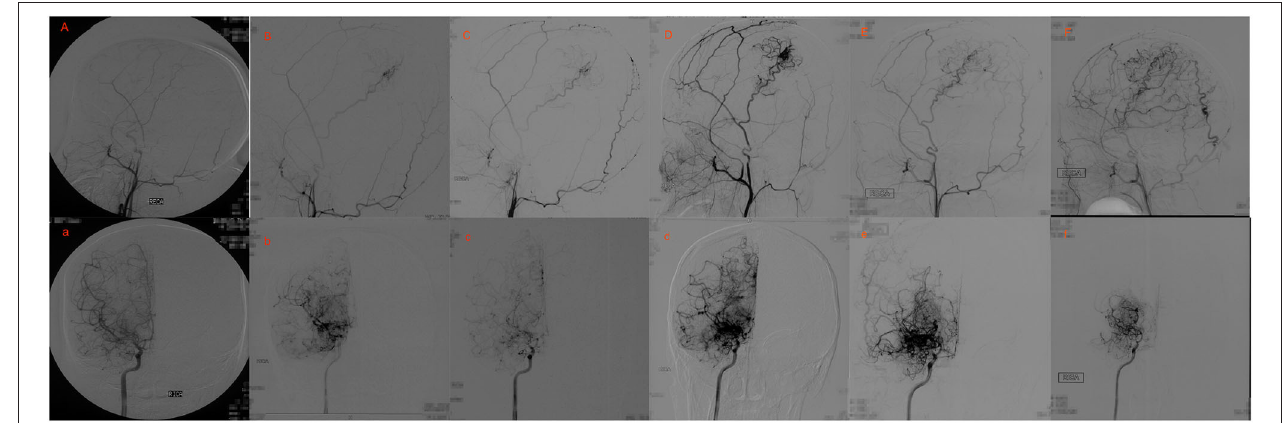
FIGURE 3 | Eighteen yrs, female. (A) a: Preoperative angiography showed stenosis at the proximal of right MCA and ACA (Suzuki gradeI), and well-developed right STA. (B,C) b,c: Postoperative angiography 0.7 and 2 years after EDAS showed almost occlusion of the right MCA and ACA with the initiation of abnormal vascular networks (Suzuki gradeII), and collateral circulation through EDAS began to develop. (D,E) d,e: Postoperative angiography 3 and 8 years after EDAS showed occlusion of right MCA and ACA with intensification of abnormal vascular networks (Suzuki grade III), and one third to two-thirds of the MCA distribution was covered